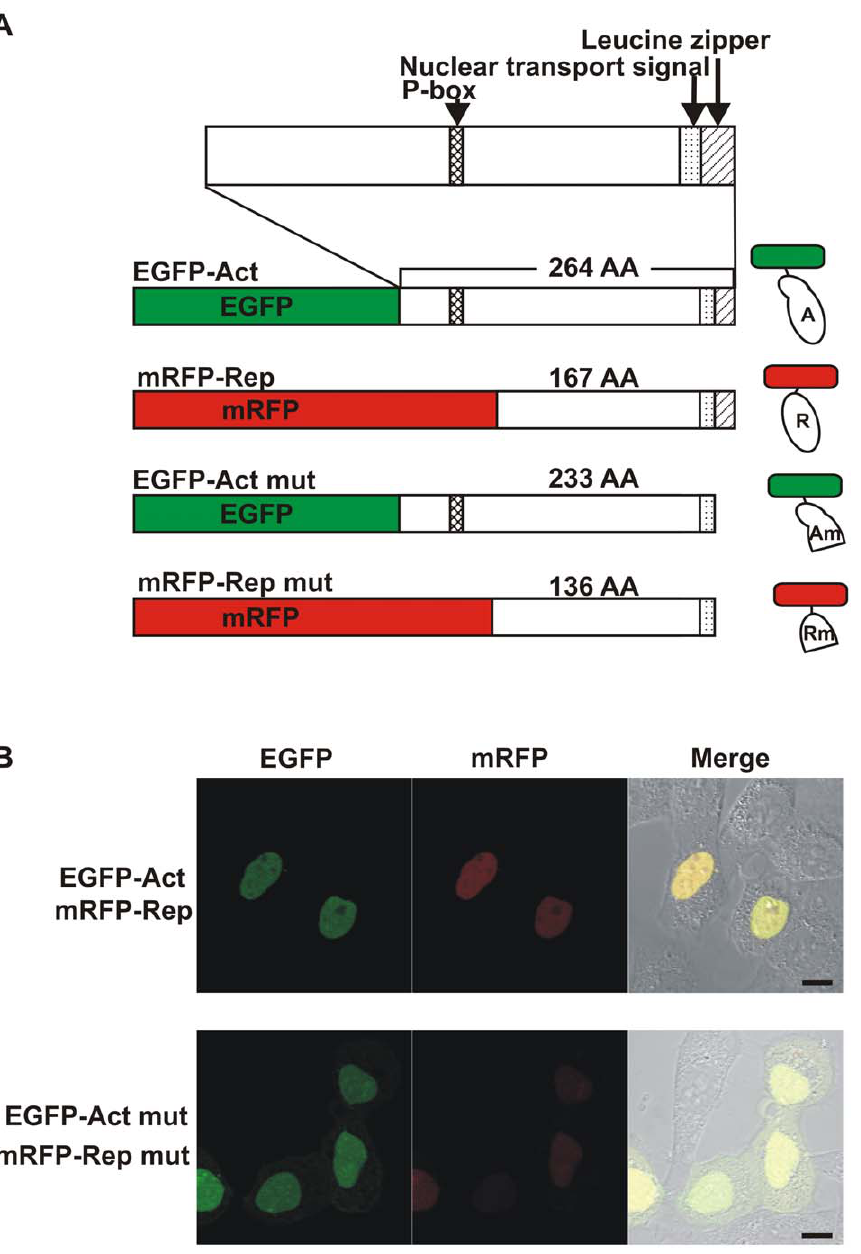
Figure 1. Expression of fluorescent-labeled CREB1 isoform proteins in HeLa cells. A, Expression constructs. Each CREB1 activator (Act) or truncated activator (Act mut) proteins was fused with EGFP (green box), and each CREB1 repressor (Rep) or truncated repressor (Rep mut) protein was fused to tandem mRFP (red box). Within CREB1 isoform proteins, the functional domains are shown as patterned boxes. Schematic diagram of the fluorescent-labeled CREB1 isoform proteins are shown on the right side. B, Confocal microscopy images of HeLa cells transfected with expression constructs encoding EGFP- (green) or mRFP- (red) labeled CREB1 isoform proteins. CREB1 isoform proteins (EGFP-Act and mRFP-Rep, top) or truncated CREB1 proteins (EGFP-Act mut and mRFP-Rep mut, bottom) were cotransfected, and the cells were imaged 16 h after transfection. Scale bars, 10 m m.